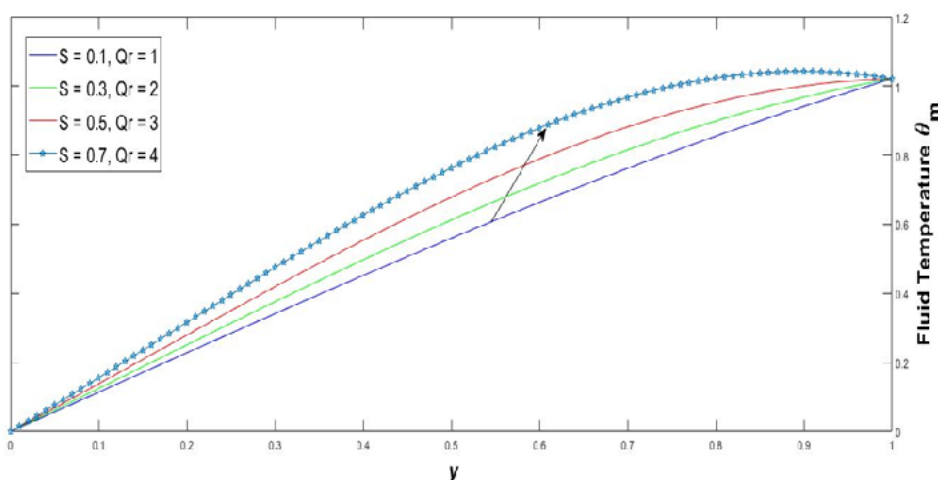
Figure 21. Temperature field for various suction parameters.